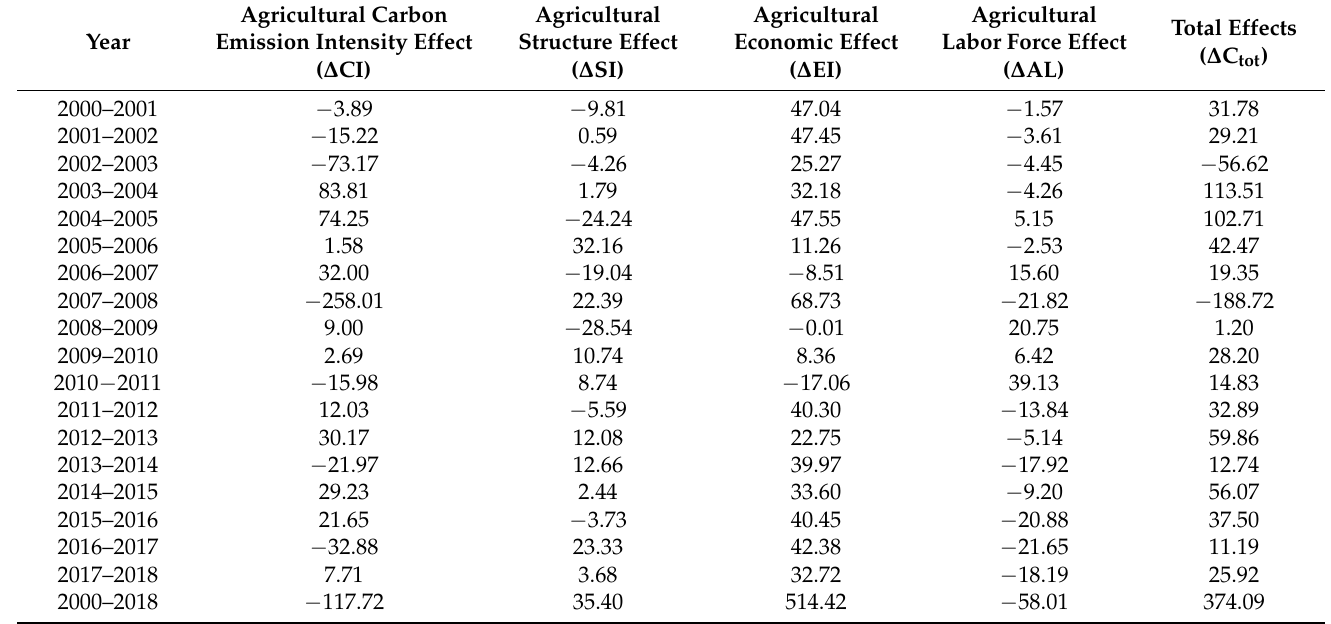
Table 8. Decomposition results of agriculture carbon emission changes in Jilin province (10 4